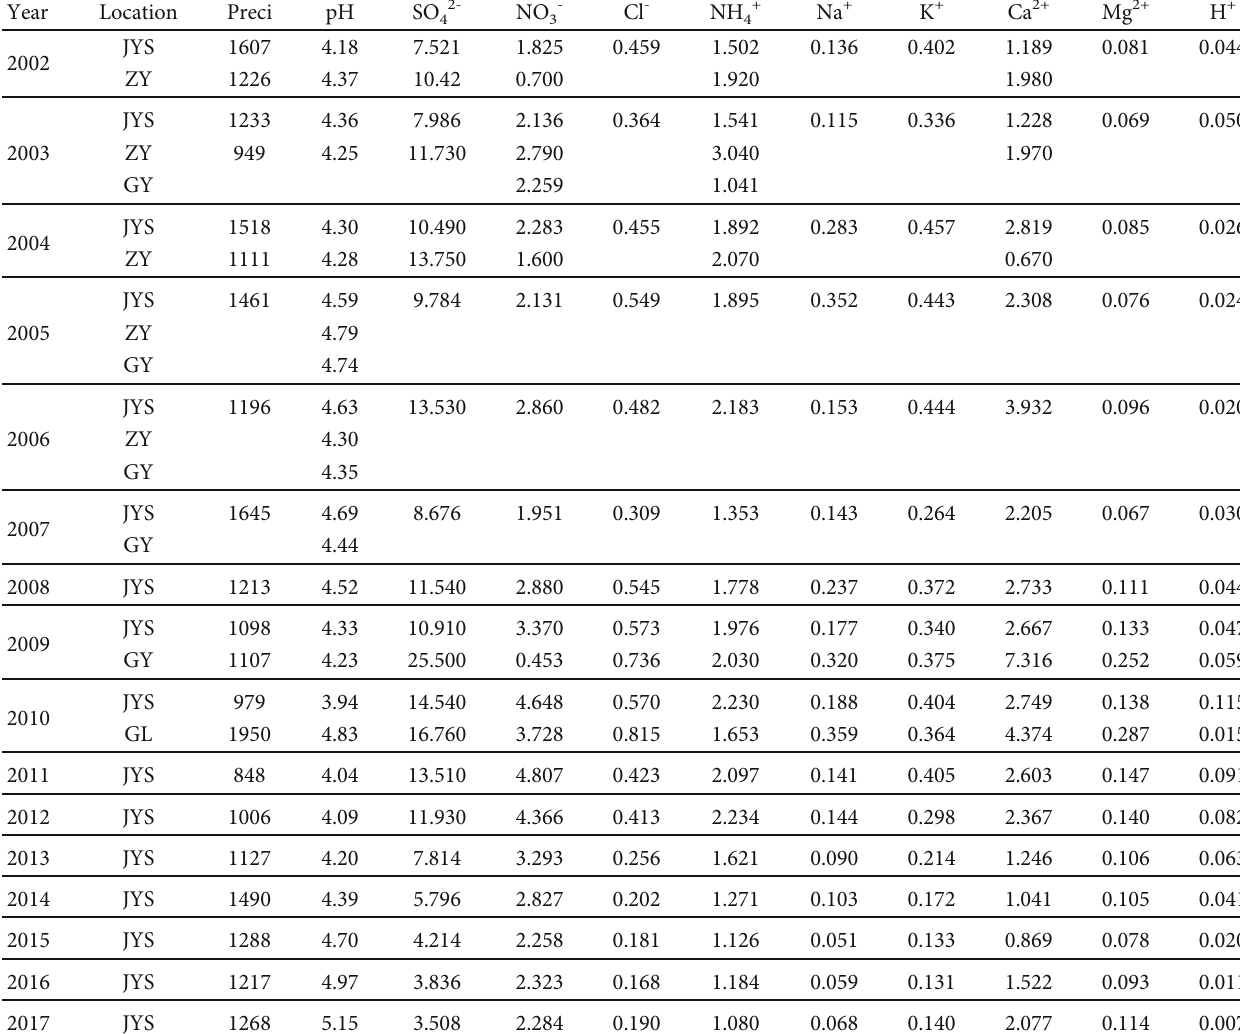
Table 1: Chemical composition of rainfall for Jinyunshan (JYS) from 2002 to 2017 [9], Zunyi (ZY) from 2002 to 2006 [34, 35], Guilin (GL) in 2010 [38], and Guiyang (GY) from 2003 to 2009 [36, 37, 40]. The unit for precipitation (Preci) is mm/yr and the unit for concentration is